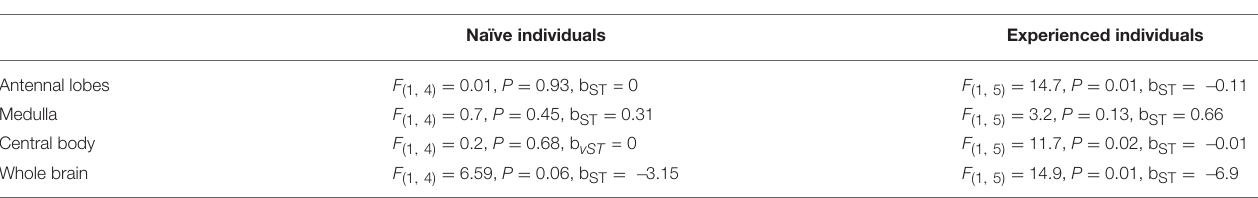
TABLE 3 | Associations between neural investment and thorax mass. Naïve individuals Experienced individuals Antennal